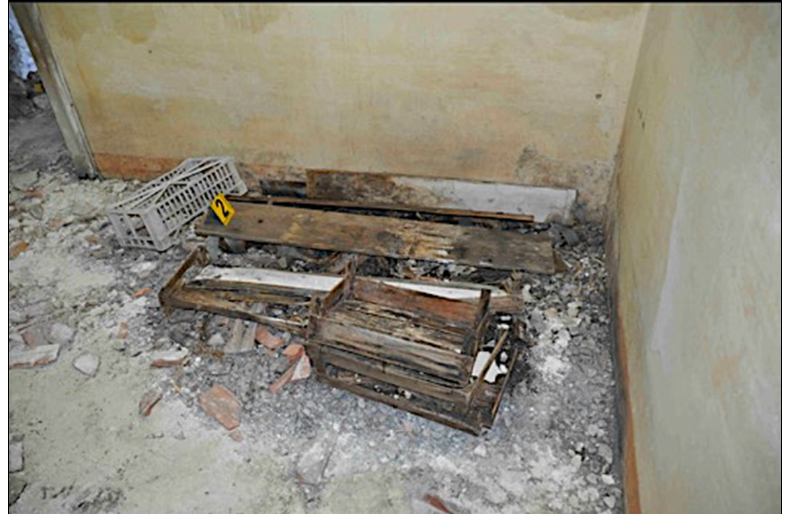
Figure 1. Place of discovery of the skeletal remains.